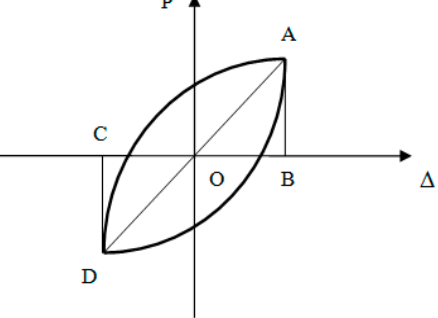
Figure 10. Calculation diagram of energy dissipation coefficient E.